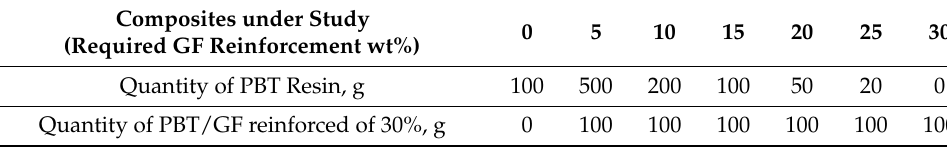
Table 1. Mixing percentage for composite materials with different GF